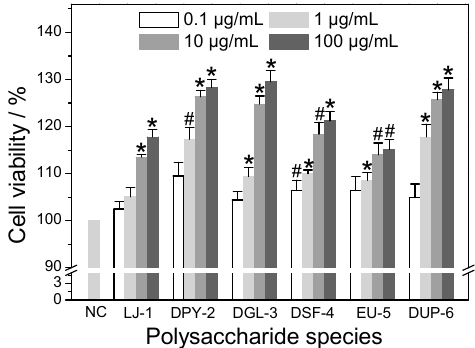
Figure 3. Cytotoxic effect of six low-molecular-weight polysaccharides with different contents of –SO 3 H group on HK-2 cells. Cells were incubated with different concentration of (0.1–100 μ g/mL) polysaccharides for 24 h and then cell viability was determined by CCK-8 assay. The control represents 100% cell viability. Data are reported as Mean ± SD ( n = 3), derived from three independent experiments. Compared with normal control group, # indicates p < 0.05, * indicates p < 0.01. NC: Normal control; LJ-1: Laminaria -1; DPY-2: degraded Porphyra -2; DGL-3: degraded Gracilaria -3; DSF-4: degraded Sargassum -4; EU-5: Eucheuma -5; DUP-6: degraded Undaria -6.